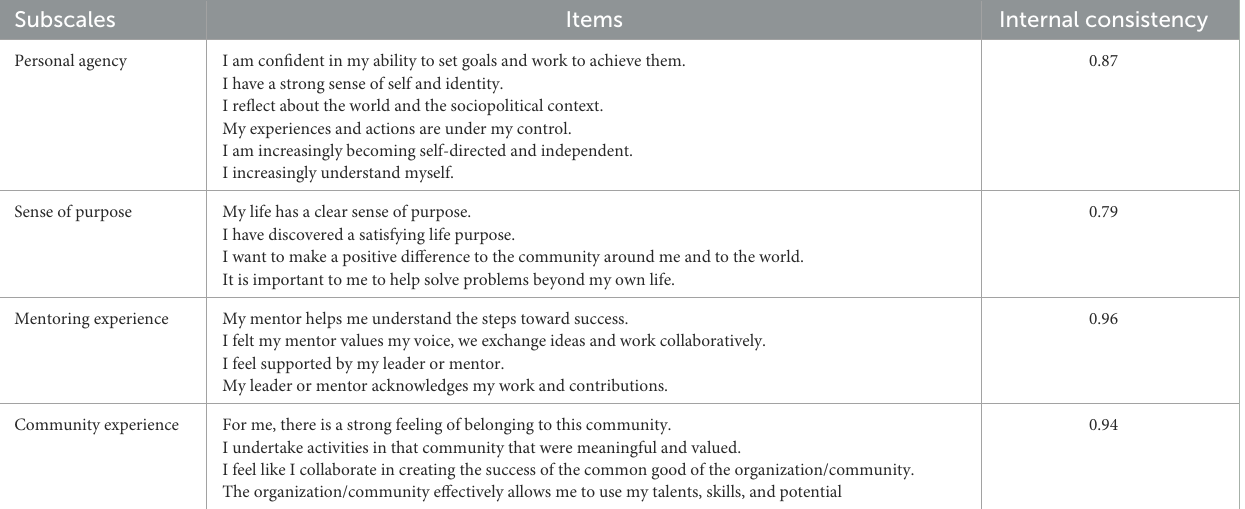
TABLE 6 Integrated empowerment in the transition to adulthood measurement scale (18-item). Subscales